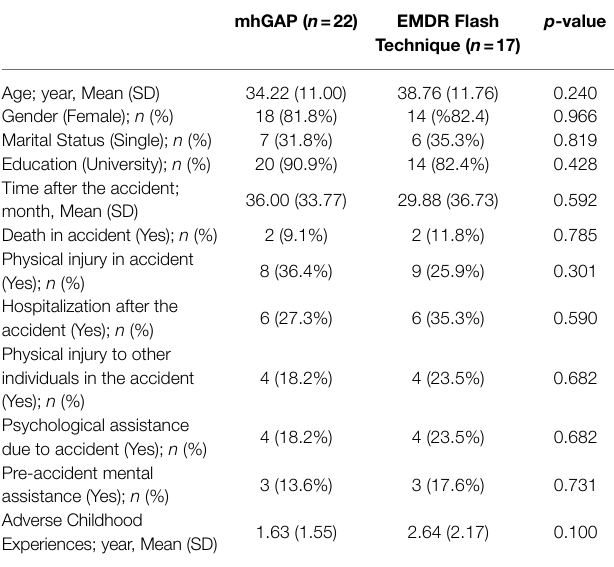
TABLE 1 | Baseline characteristics of mhGAP and flash technique